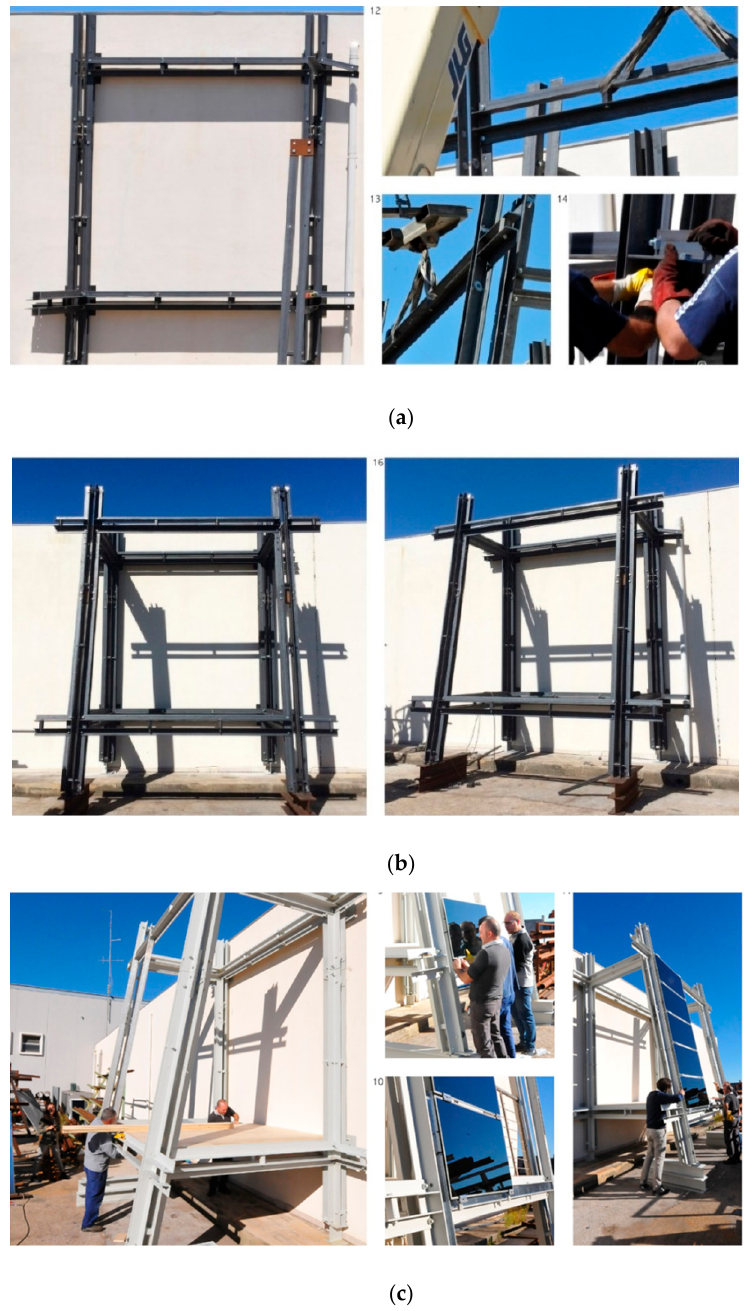
Figure 3. Construction of the prototype [42]: ( a ) Assembly phases of the steel frame; ( b ) final steel frame; and ( c ) thermal solar and photovoltaic (PV) panels installation.